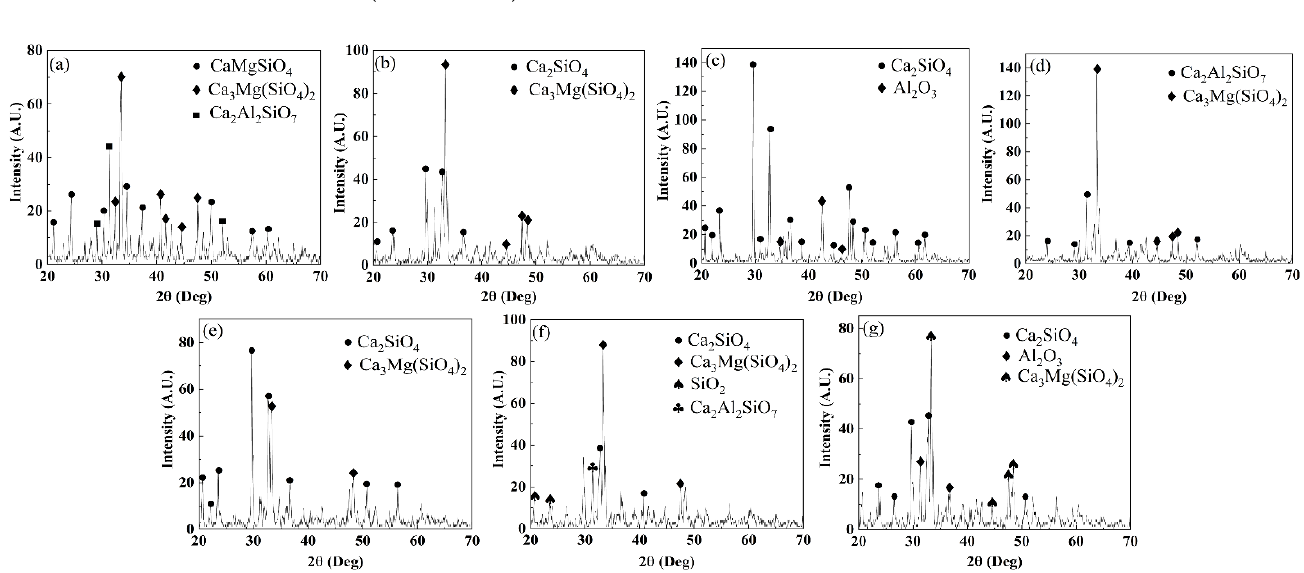
Figure 4. XRD results of the slags after smelting with different tests: ( a ) 1#, R = 1.5; ( b ) 2#, R = 2.0; ( c ) 3#, R = 2.5; ( d ) 4#, Al 2 O 3 = 7.5%; ( e ) 5#, Al 2 O 3 = 2.5%; ( f ) 6#, MgO = 7.5%; ( g ) 7#, MgO = 2.5%.